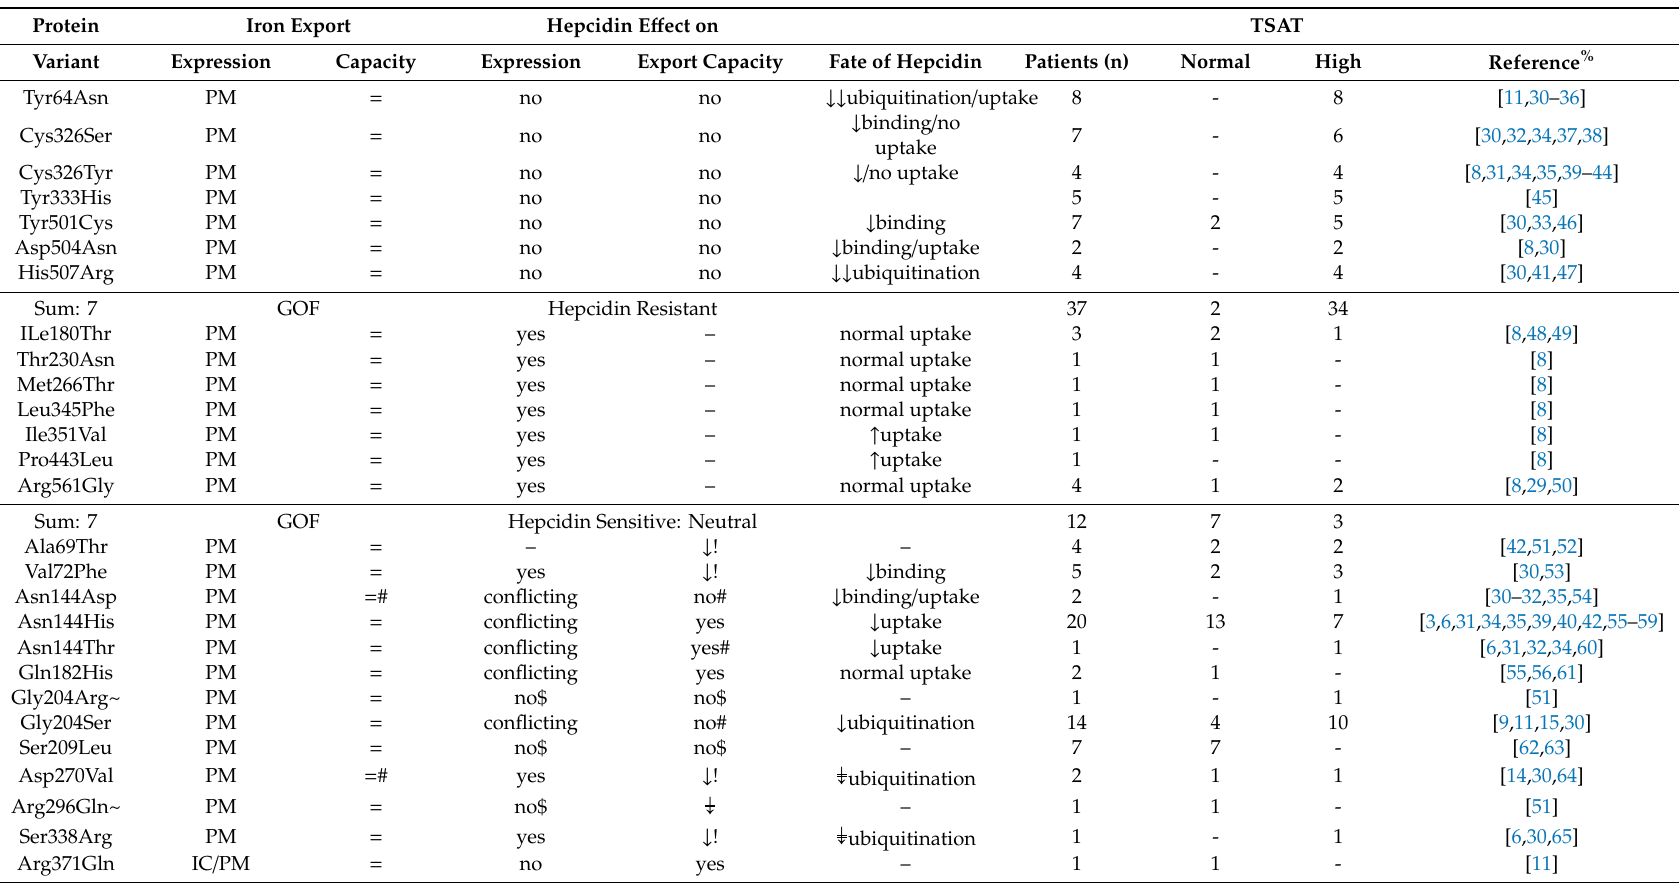
Table 2. Functional and phenotypical characteristics of 359 patients with 60 ferroportin variants. GOF: gain of function, LOF: loss of